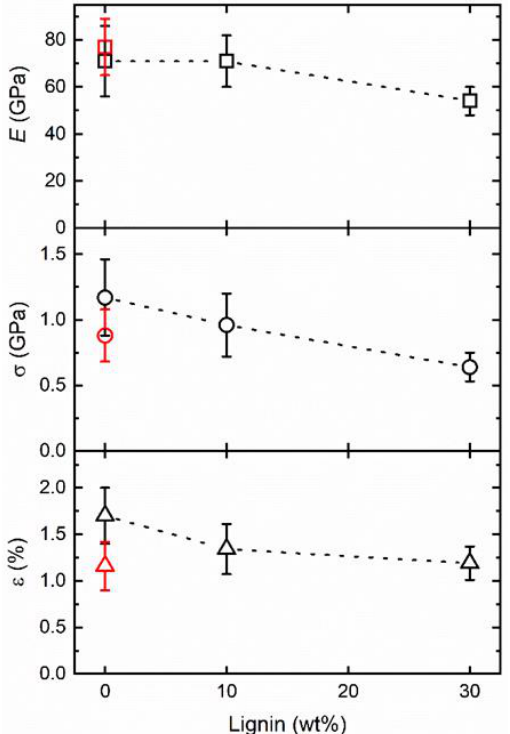
Figure 7. Effect of lignin content in the System S precursors on the tensile properties of CFs made using batchwise conversion. Black: CFs derived with stabilization and carbonization profiles having final temperatures of 250 °C and 1000 °C, respectively. Red: CFs derived with stabilization and carbonization profiles having final temperatures of 275 °C and 1100 °C, respectively. E = Young’s modulus; σ = tensile strength; ε = elongation at break.